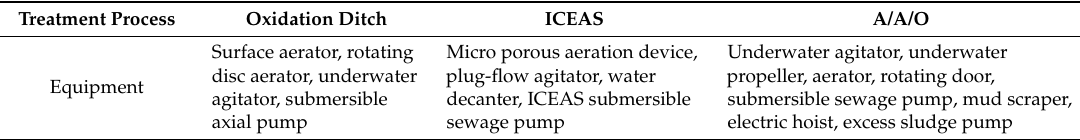
Table 4. Comparison between three types of sewage treatment process